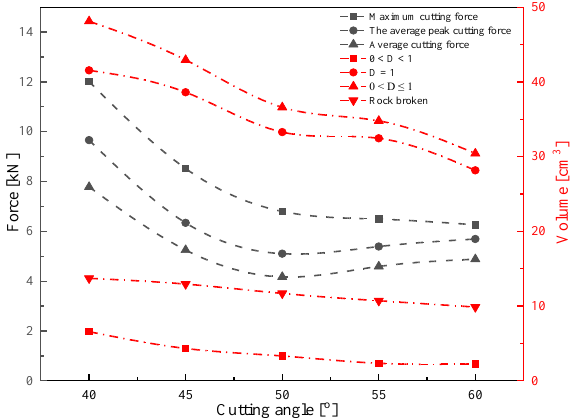
Figure 12. The rock damage and broken volume with various cutting angles.